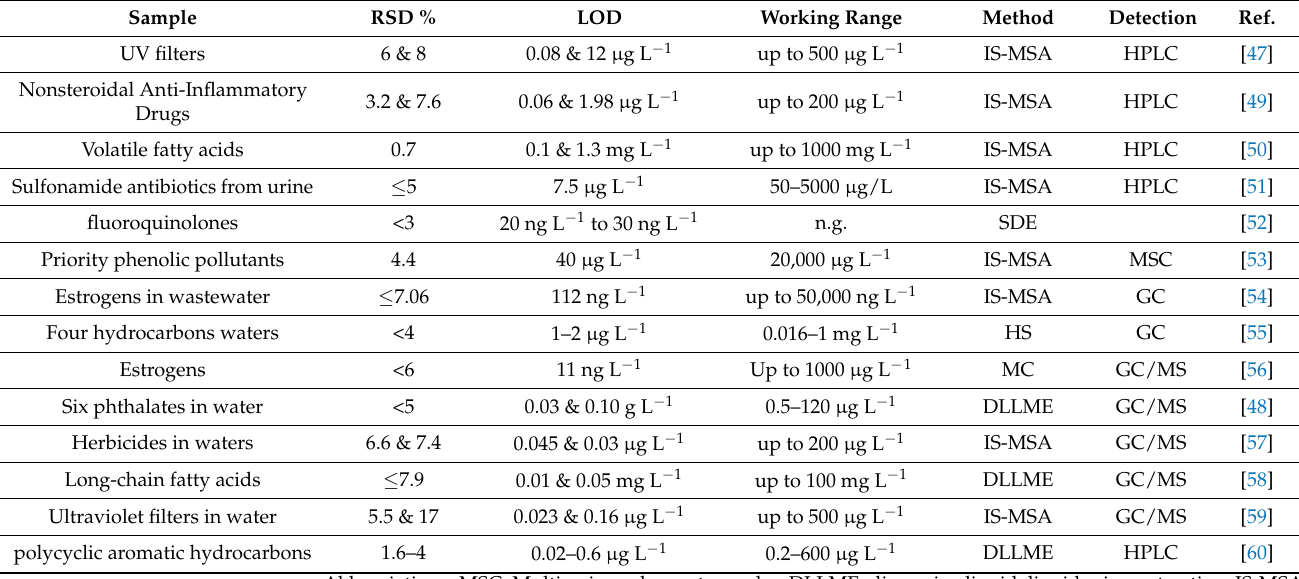
Figure 14. Chromatograms of tap water analyzed with the in-syringe-DLLME–GC/MS: (A) non- spiked and (B) spiked with 5 µ g L − 1 of studied phenyl phthalates. Peaks numbers correspond to: (1) dimethyl phthalate, (2) diethyl phthalate, (3) benzyl benzoate (ICS), (4) dibutyl phthalate, (5) butylbenzyl phthalate, (6) diethylhexyl phthalate, (7) di-n-octyl phthalate [48]. Table 2. Several LIS methods hyphenated with